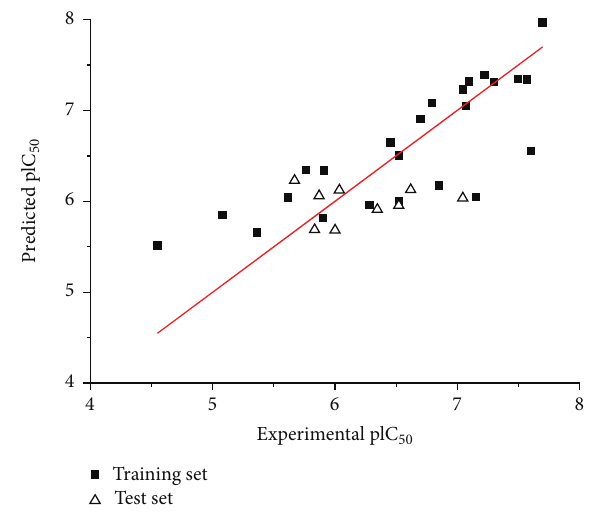
Figure 4: Correlation between experimental and predicted activi- ties of SOMFA model for the training set and test